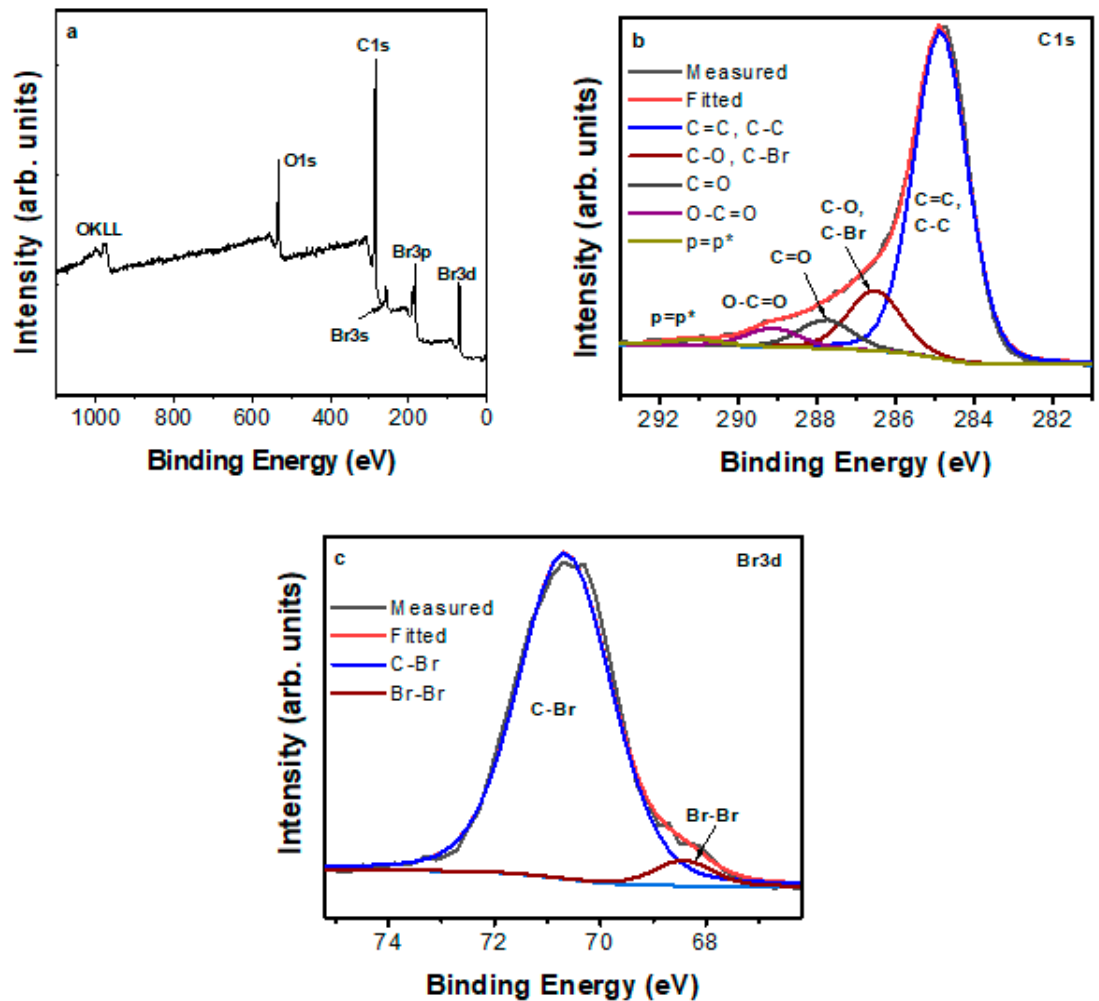
Figure 4. ( a ) X-ray photoelectron spectroscopy (XPS) survey spectrum and ( b , c ) deconvoluted C1s and Br3d high resolution spectra of the sample.